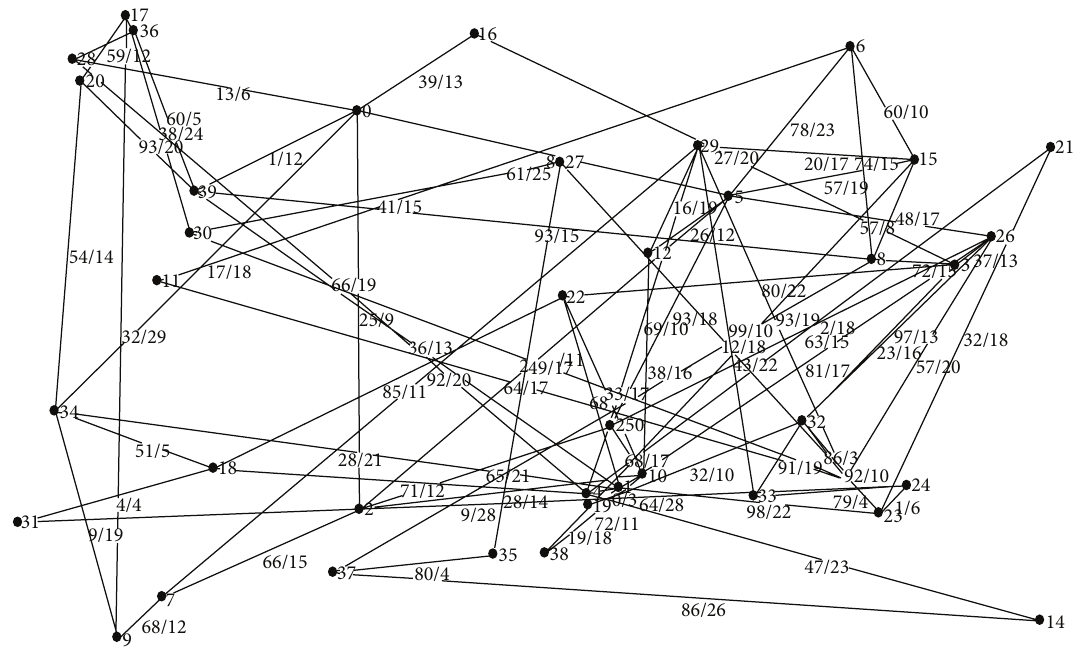
Figure 5: A randomly generated network with 40 nodes and average degree four.